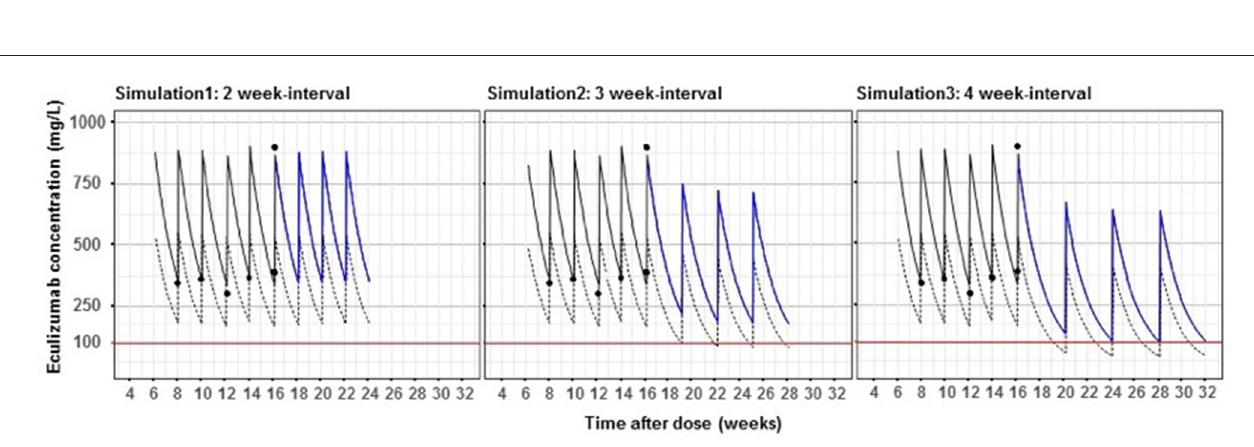
FIGURE 3 | Bayesian pharmacokinetic modeling of maintenance eculizumab dosing in an aHUS patient. Dashed lines show the population pharmacokinetic curve in aHUS patients based on mean pharmacokinetic parameters in Federal Drug Administration approval documents. Solid lines show this patient’s pharmacokinetic profile based on five eculizumab levels (black circles). Red lines show the recommended concentration of eculizumab to control aHUS. Blue lines are simulated pharmacokinetic profiles of this patient with 2, 3, and 4 week-interval dosing.